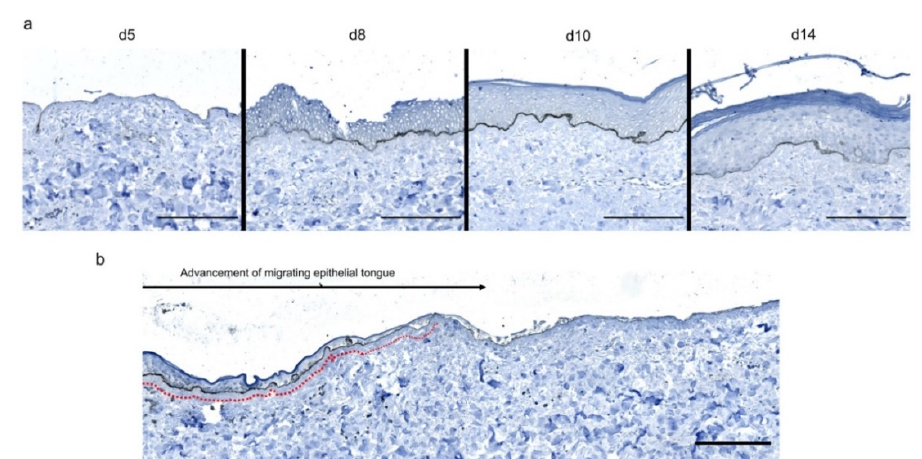
Figure 6. Kinetics of the dermo-epidermal junction (DEJ) repair in ex vivo cultured human skin explants submitted to 10 s long experimental burn injury. A 10 s burn was carried out on ex vivo cultured human skin explants and collagen VII immunostaining was performed on skin samples of the burn area harvested at different time points post burn (days 5, 8, 10, and 14. ( a ) In the center of the burnt area, no collagen VII remained detectable on day 5. However, in the same area, neosynthesized collagen VII was observed at the DEJ of the re-epithelialized epidermis on day 8 and onward. ( b ) In the wound margins, collagen VII staining was observed at the DEJ of the epidermal tongue formed by a few layers of cells. Experiments were performed on skin explants derived from three donors. Scale bar: 100 µm.